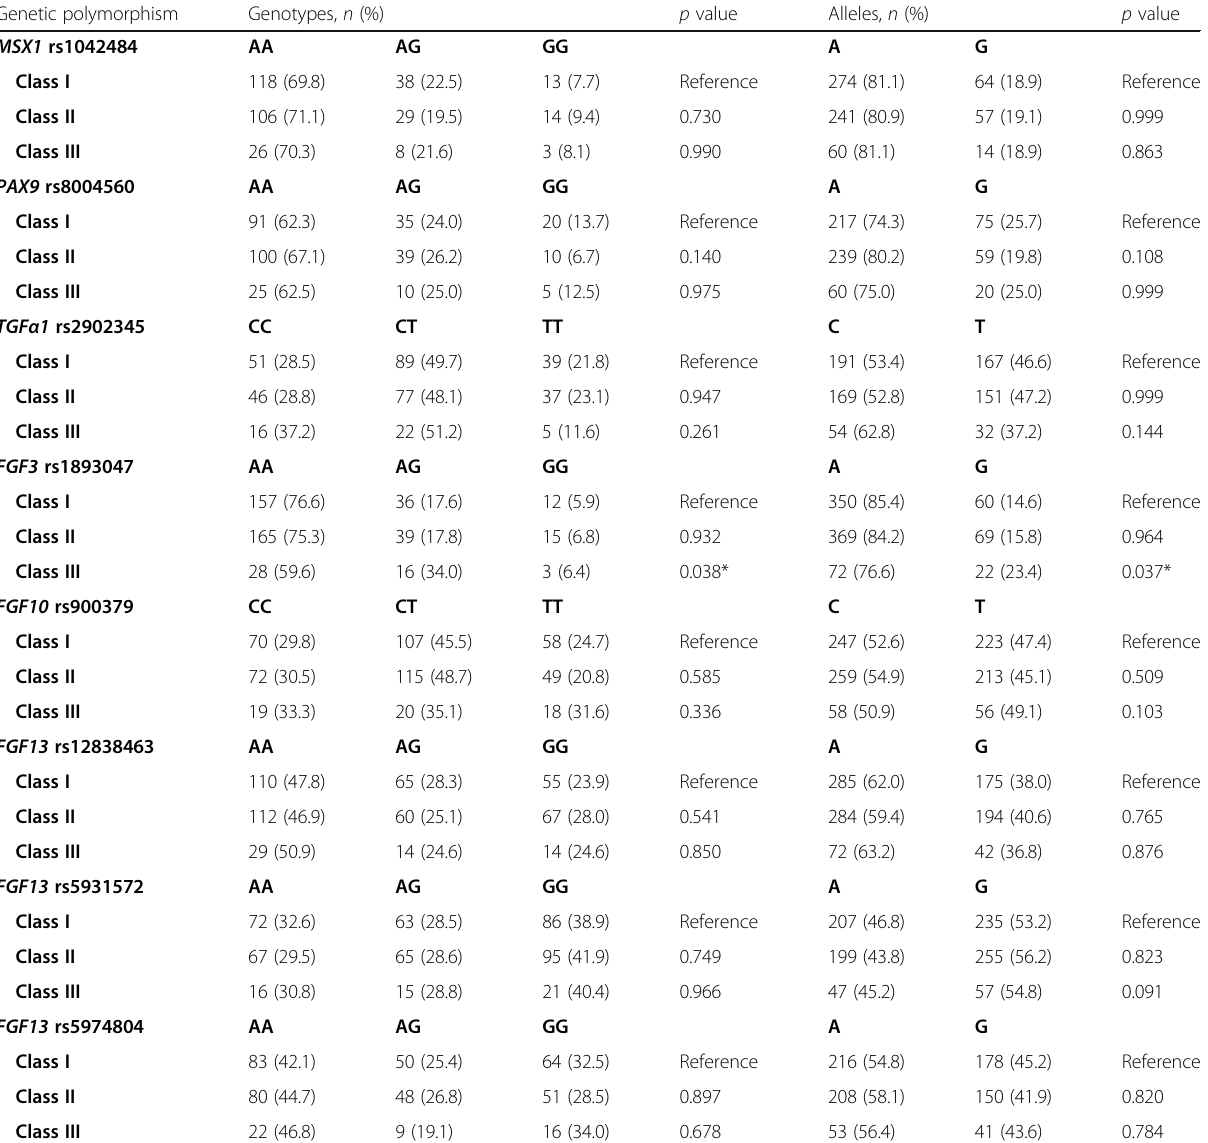
Table 3 Genotype and allele distribution among class I, class II and class III skeletal malocclusions Genetic